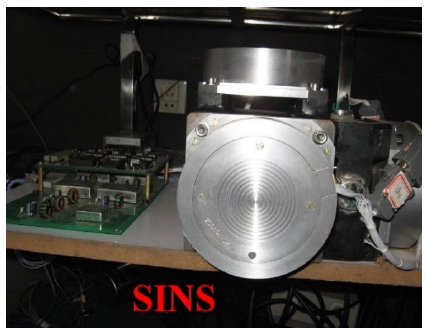
Figure 3. The test vehicle platform.